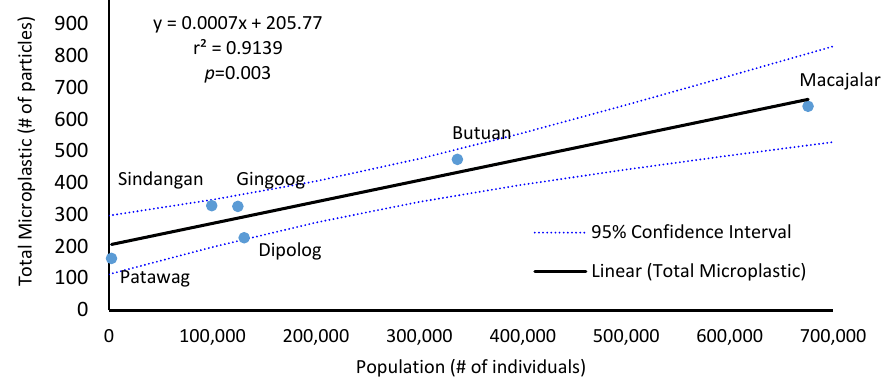
y = 0.0007x + 205.77 r² = 0.9139 p =0.003